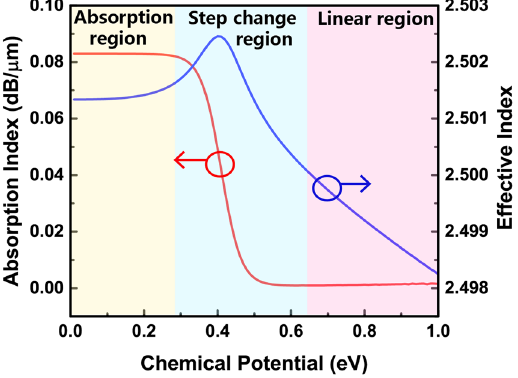
Figure 2. Simulation results of Re( n eff ) and absorption ofgraphene-oxide-silicon (GOS) modulator as functions of the chemical